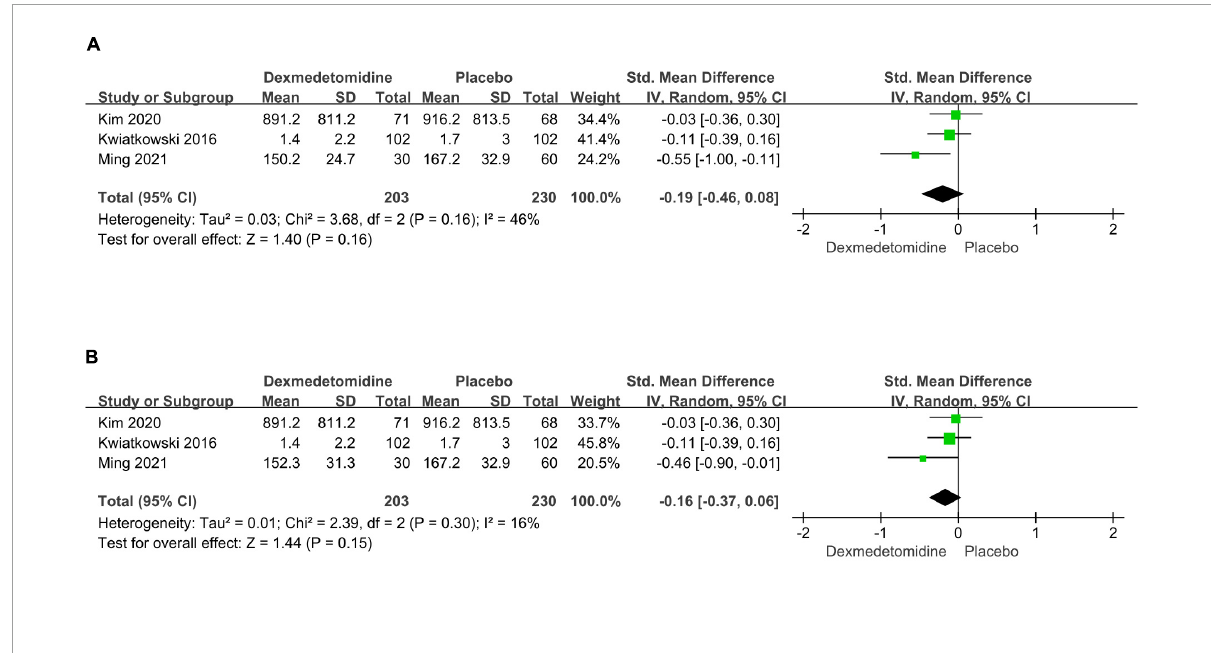
FIGURE6 Pooled results of postoperative duration of ventilation time between dexmedetomidine and placebo groups [different dexmedetomidine dose 0.2 µ g/kg/h (A) and 0.4 µ g/kg/h (B) according to the study from Ming et al.].